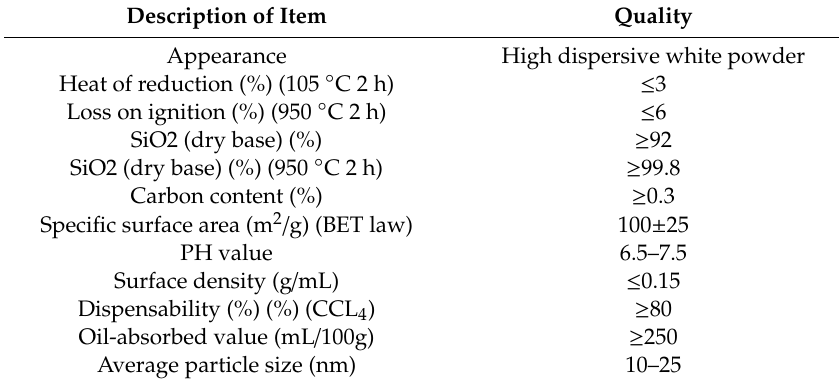
Table 2. Physical and chemical composition of nano-silica